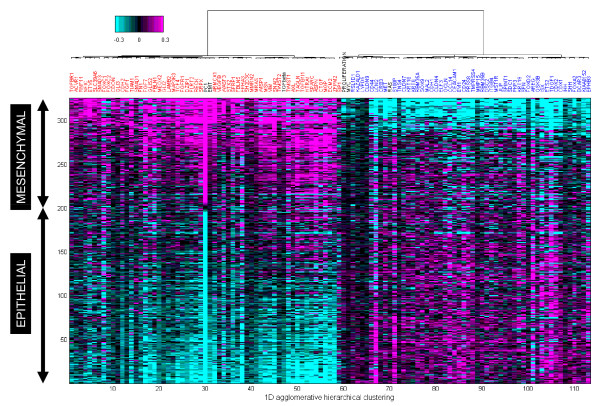
Hierarchical cluster analysis of the top 100 genes assessed from a text mining approach were strongly associated with the EMT program as shown on 326 MCC colon tumors sorted by PC1. The 100 gene set contains individual genes (CDH1, CLDN9, FGFR1, FN1, TWIST 1 & 2, AXL, VIM) as well as signatures of genes (PC1, EMT, TGFbeta, Proliferation, MYC, and RAS) that are up-regulated in mesenchymal tumors (shown in magenta), and that are up-regulated in epithelial tumors (shown in cyan). Names for the relevant gene signatures are shown in black. Samples (rows) are sorted by PC1. Genes (columns) are clustered using Pearson correlation and Ward linkage. Heatmap shows mean-centered probe intensities.